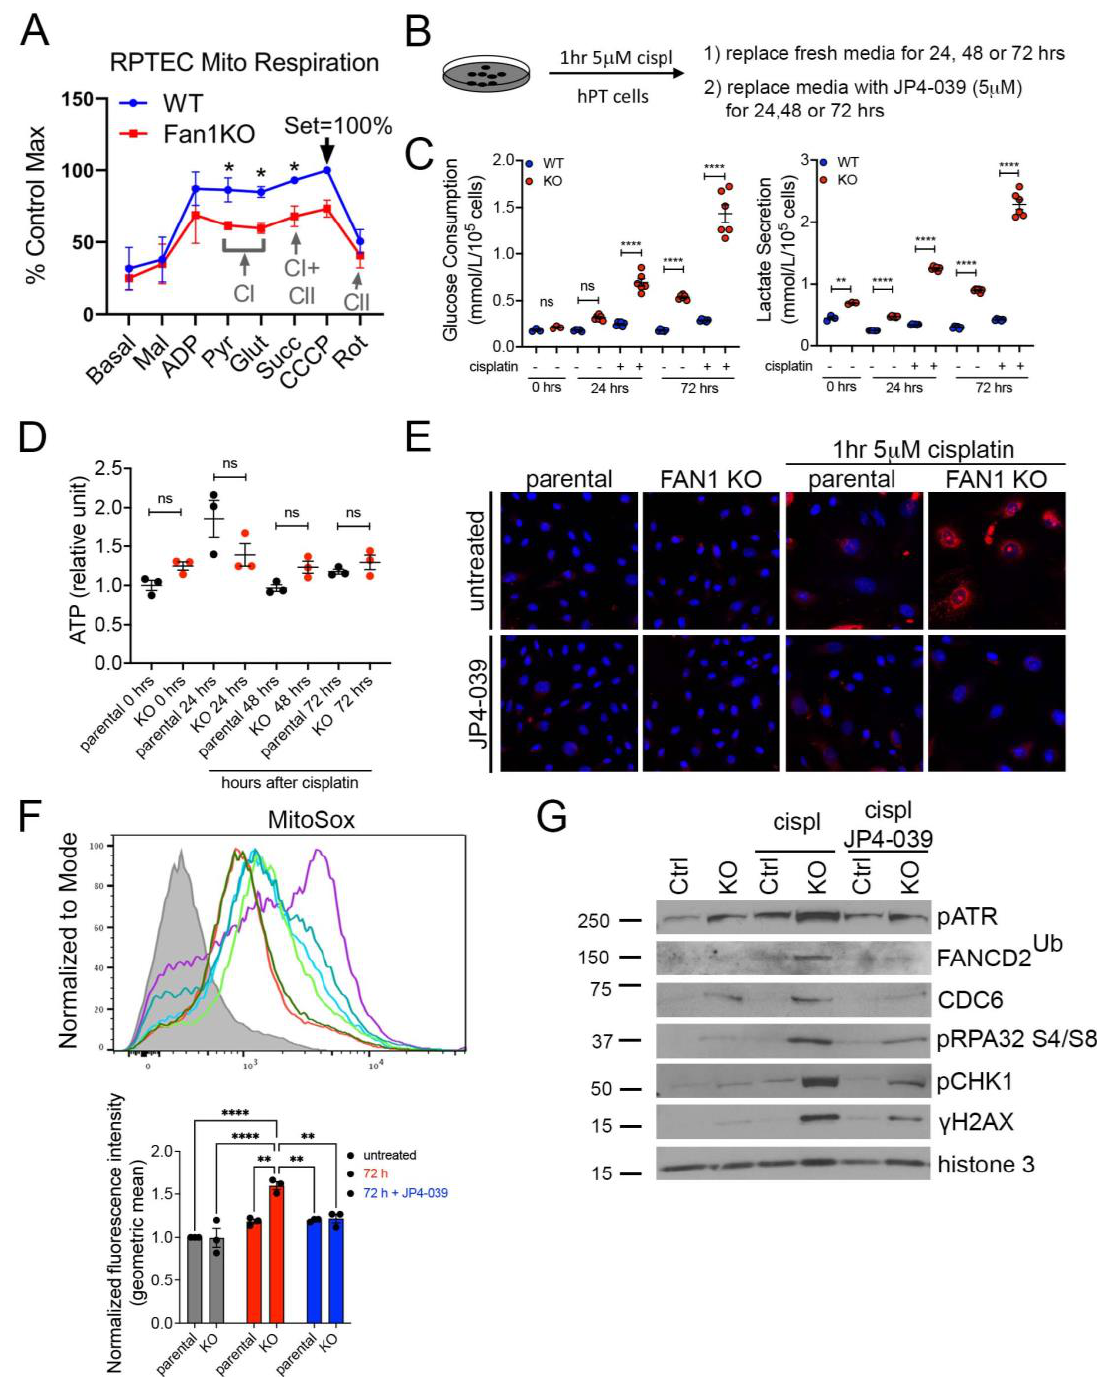
Figure 3. FAN1KO renal tubular epithelial cells have impaired mitochondrial metabolism and in- creased ROS production. ( A ) Representative oxygen consumption traces for parental (WT) and FAN1KO hRTEC mitochondria using Oroboros high-resolution respirometry. Basal, baseline respi- ration; CI, Electron Transport Complex I; CII, Electron Transport Complex II; Mal, malate; ADP, adenosine diphosphate; Pyr, pyruvate; Glut, glutamate; Succ, succinate; CCCP, carbonyl cyanide m-chlorophenylhydrazone; Rot, rotenone. Rotenone (CI) inhibitor was used to separate the contri- butions of complexes I and II. ( B ) Overview of cisplatin and JP4-039 treatment protocols in FAN1KO human renal tubular epithelial cells. Cells were seeded for 24 h and left untreated or treated with 5 μM cisplatin for 1 h, followed by two rises with PBS and replaced with fresh media. When JP4 -039 treatment was performed following cisplatin treatment, cells were daily provided with fresh media ± JP4- 039 (5 μM) for the duration of the culture period. ( C ) Glucose consumption and lactose secre- tion measurements. Parental and FAN1KO hRTECs were ± treated with cisplatin, the media were harvested, and glucose consumption and lactate production were quantified (n = 6). ( D ) ATP meas- urement in parental and FAN1KO hRTECs at indicated time points after treatment with cisplatin. Data are shown after normalizing ATP levels in untreated parental cells. N = 3 independent experi- ments. ( E ) Representative images of MitoSox staining in parental and FAN1KO hRTECs. Cells were